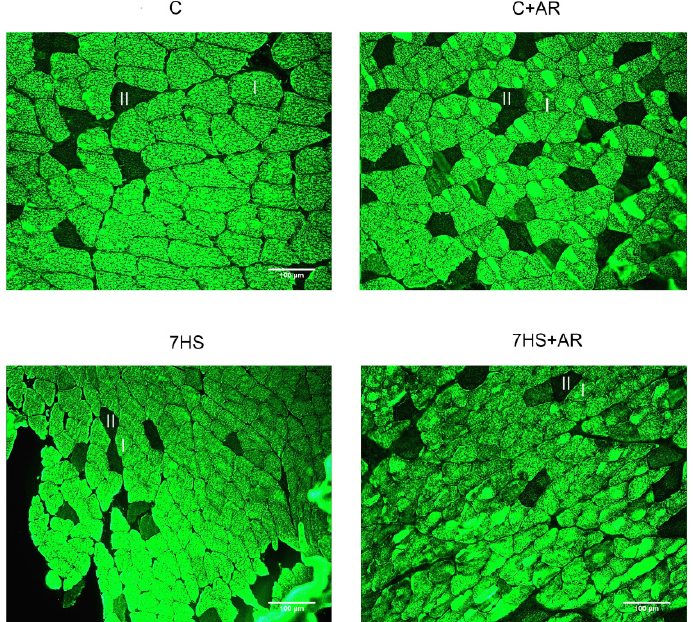
Figure 1. Representative images showing type I fibers (I, green) and type II fibers (II, dark) in rat soleus muscle. C, vivarium control group, C + AR, vivarium control rats + daily injections of GSK-3 inhibitor (AR-A014418) for 7 days, 7HS, hindlimb suspension for 7 days, 7HS + AR, 7-day hindlimb suspension + daily injections of GSK-3 inhibitor (AR-A014418). Scale bar, 100 μ m.